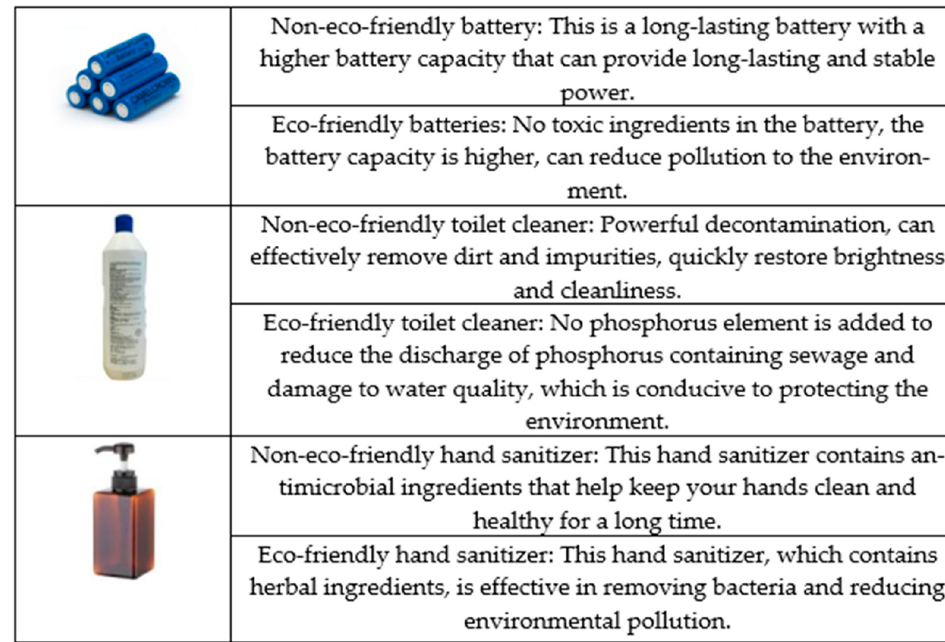
Figure 1. N on-eco-friendly products and Eco-friendly products in the experiments. Figure 1. Non-eco-friendly products and Eco-friendly products in the experiments. We invited 40 participants (M age = 29.56, female = 64%) to verify the above results, and each product was rated on a 7-point scale (1 = extremely non-eco friendly, 7 = extremely eco- friendly). The results showed that there was a significant difference in the eco-friendliness score between the two groups. The eco-friendliness of the eco-friendly battery (M = 5.50, SD = 0.99) was significantly higher than the non-eco-friendly battery (M = 3.38, SD =